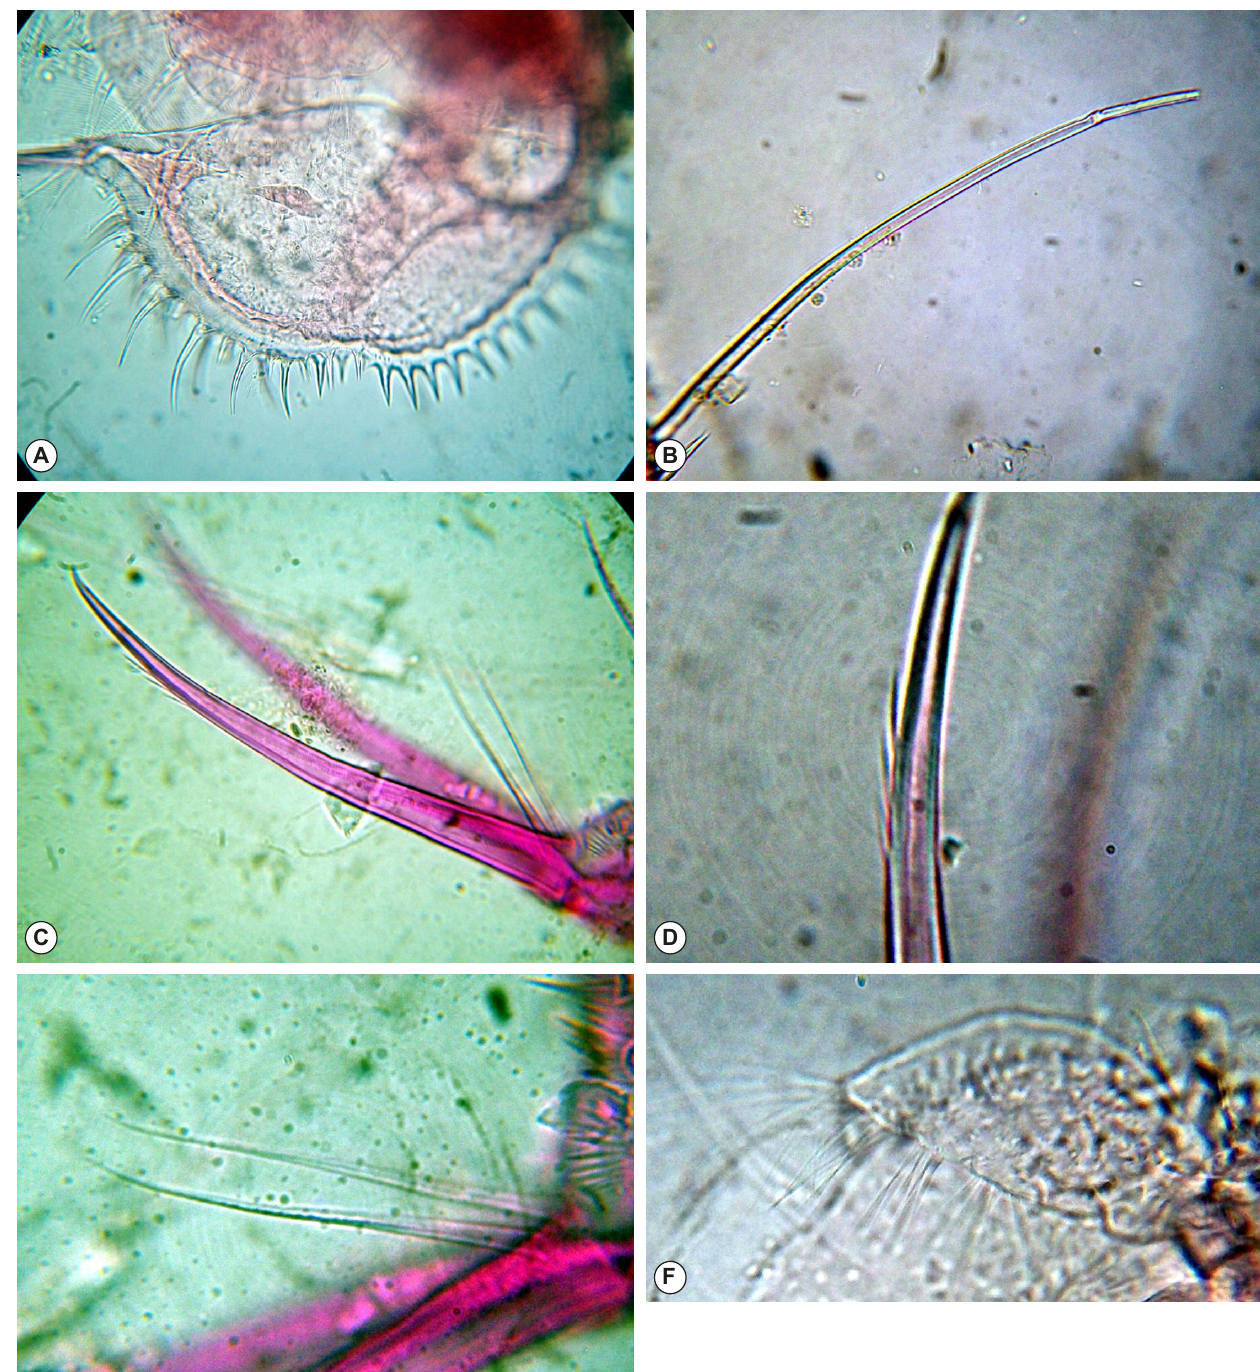
Figure 5. Ilyocriptus paranaensis